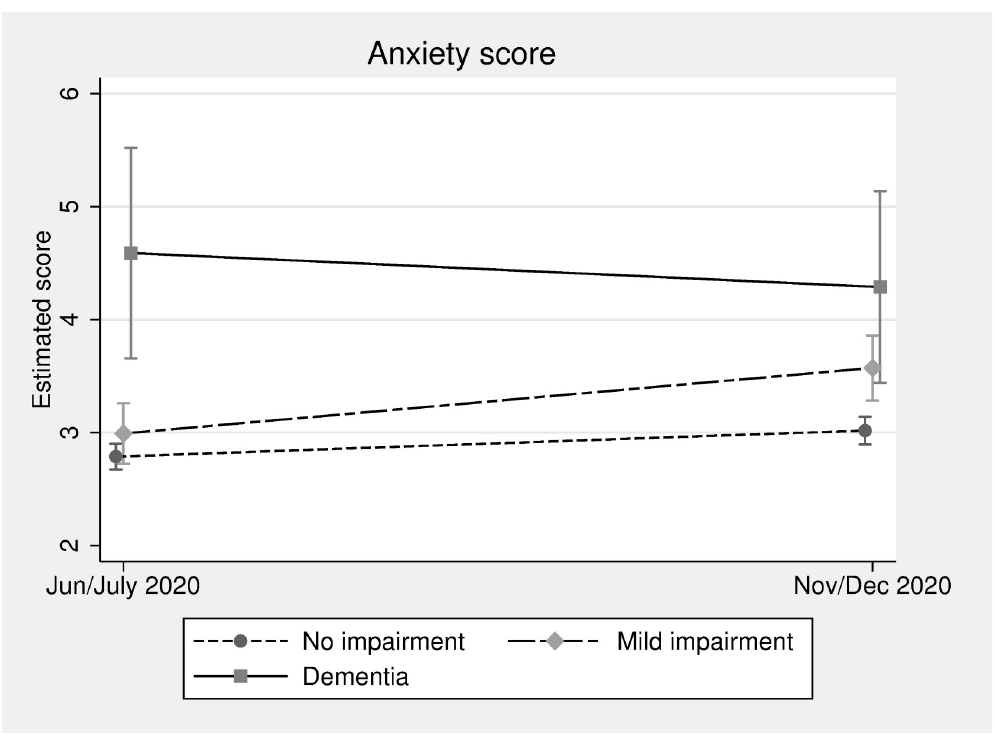
Fig 2. Anxiety score (GAD-7) over time by cognitive function (estimated scores and 95% confidence intervals, adjusted for all available covariates).